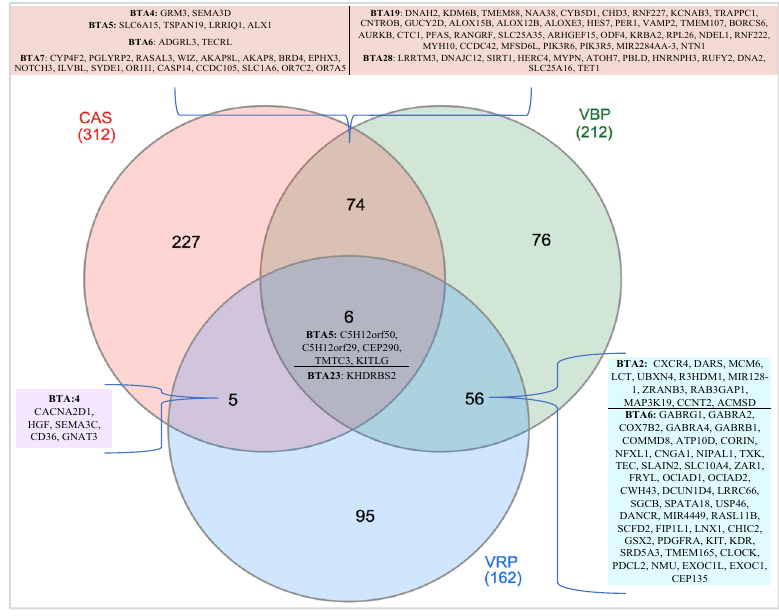
Figure 4. Venn diagram of the genes annotated in the TOP_ROH of CAS, VBP and VRP. Table 5. Details of the QTL associated with bovine